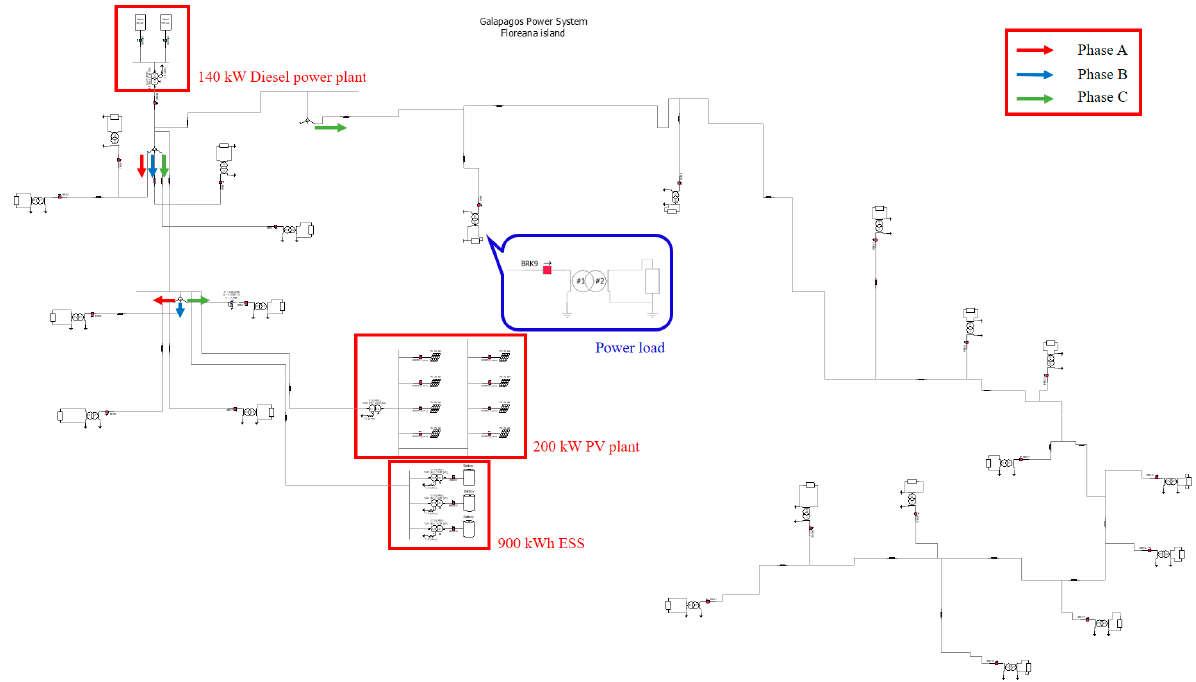
Figure 7. Floreana island simulation model in PSCAD/EMTDC.